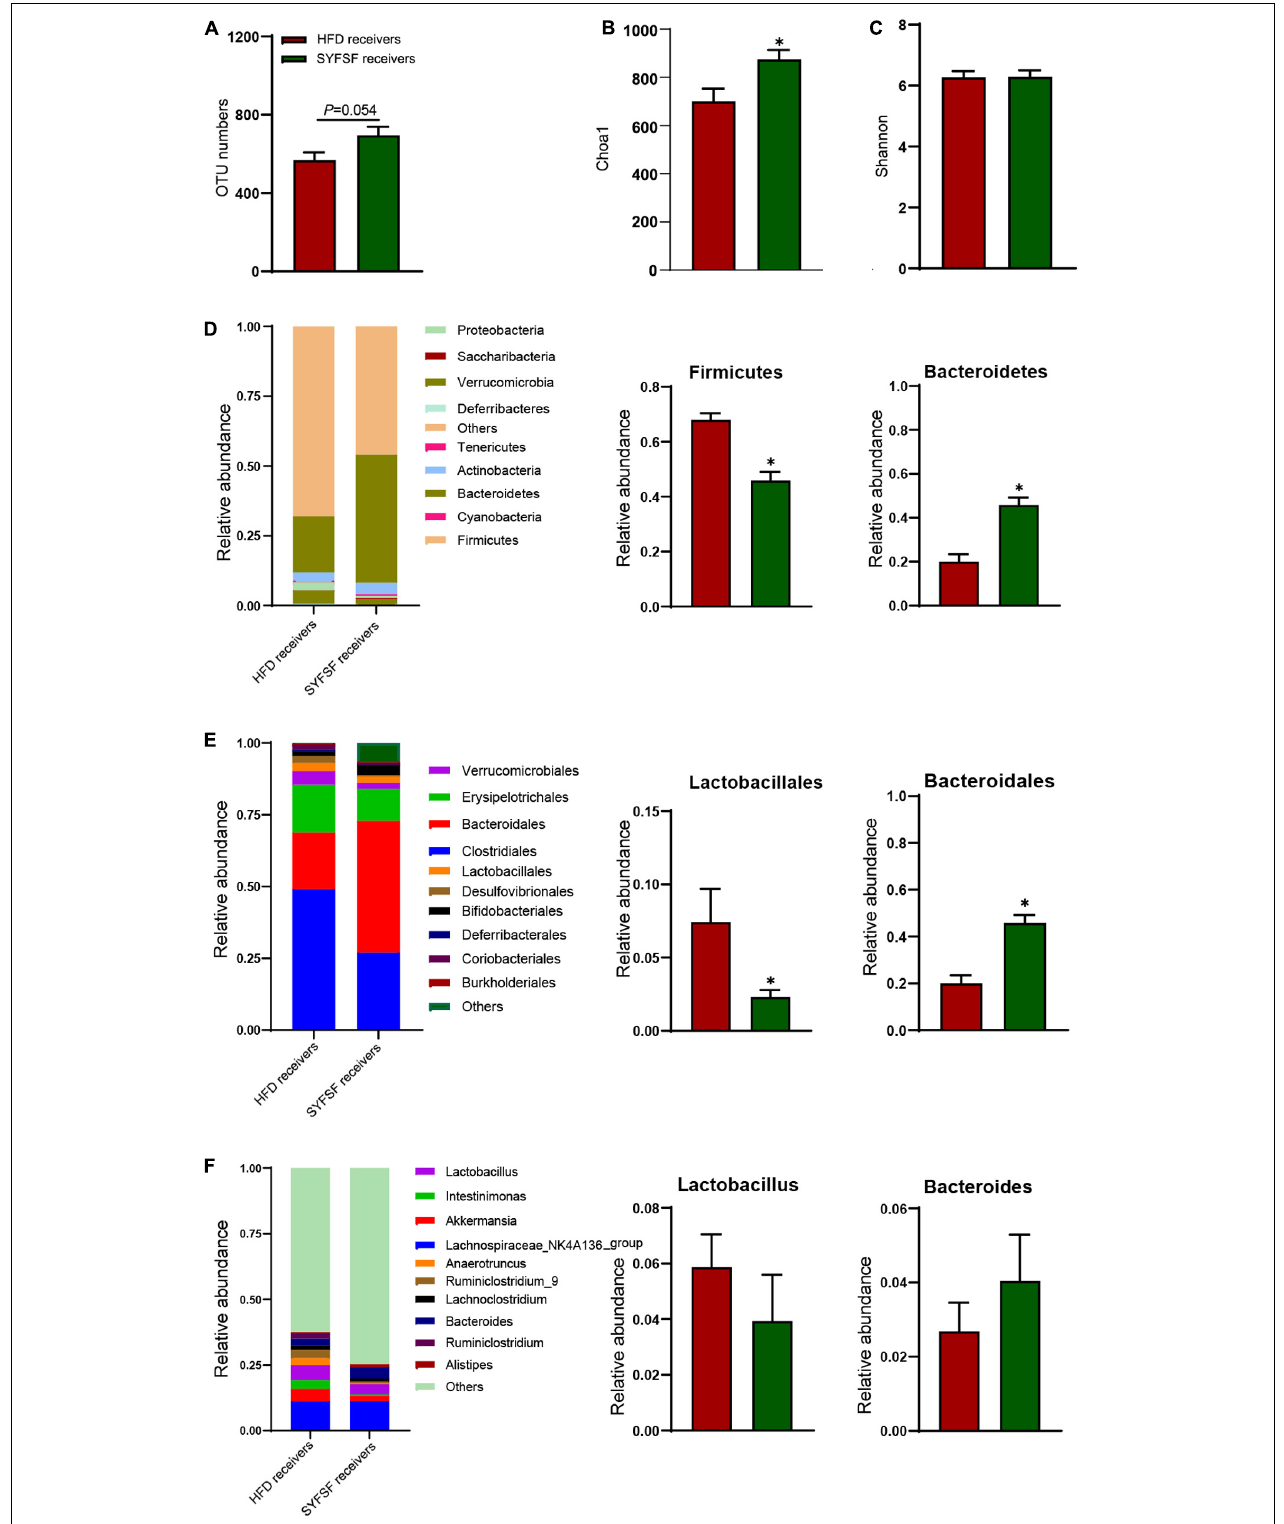
FIGURE 6 | Gut microbiota in response to fecal microbiota transfer ( n = 6). (A) OTU numbers analysis. (B) Chao1 index in a-diversity analysis. (C) Shannon index in a-diversity analysis. (D) Microbiota compositions at the phylum level. (E) Microbiota compositions at the order level. (F) Microbiota compositions at the genus level. Data are presented as means ± SEM. Differences were assessed by ANOVA. ∗ P < 0.05.